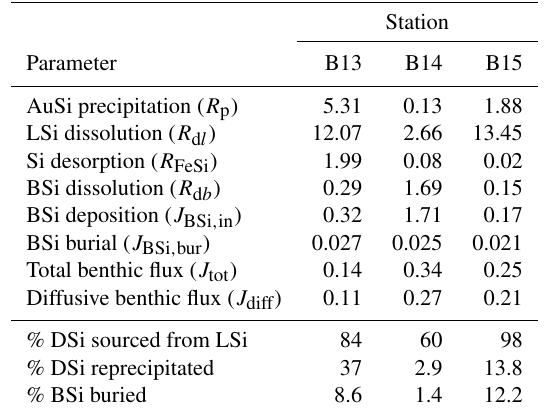
Table 2. Depth-integrated reaction rates of the steady state, best- fit simulations across the upper 50cm of sediment (Fig. 3), as well as calculated BSi deposition rates and model-derived DSi benthic fluxes. All magnitudes are given in units of mmolSim − 2 d − 1